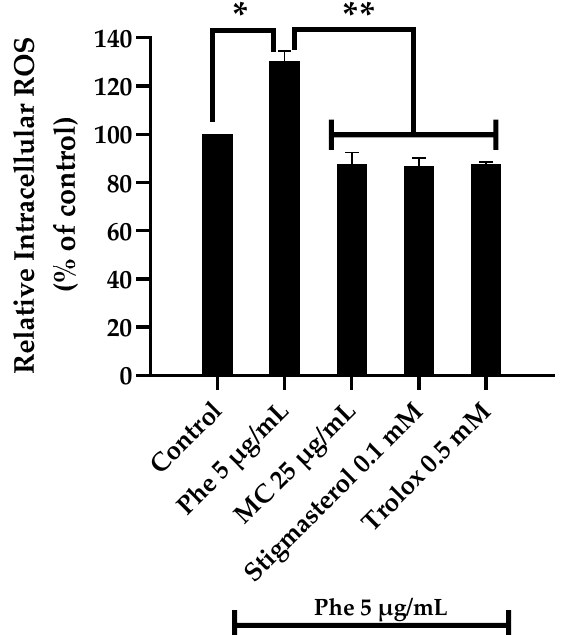
Figure 3. The protective effect of MC on PAHs-induced intracellular ROS formation; * p < 0.05 vs. control (0 μ g/mL Phe); ** p < 0.05 vs. Phe alone; * p value was 0.000 in 5 μ g/mL Phe alone and ** p values were 0.000 in Phe combined with 25 μ g/mL MC, 0.1 mM stigmasterol, and 0.5 mM trolox groups. Compared with the control group, there was no significant difference in 25 μ g/mL MC, 0.1 mM stigmasterol, and 0.5 mM trolox groups; n = 3.